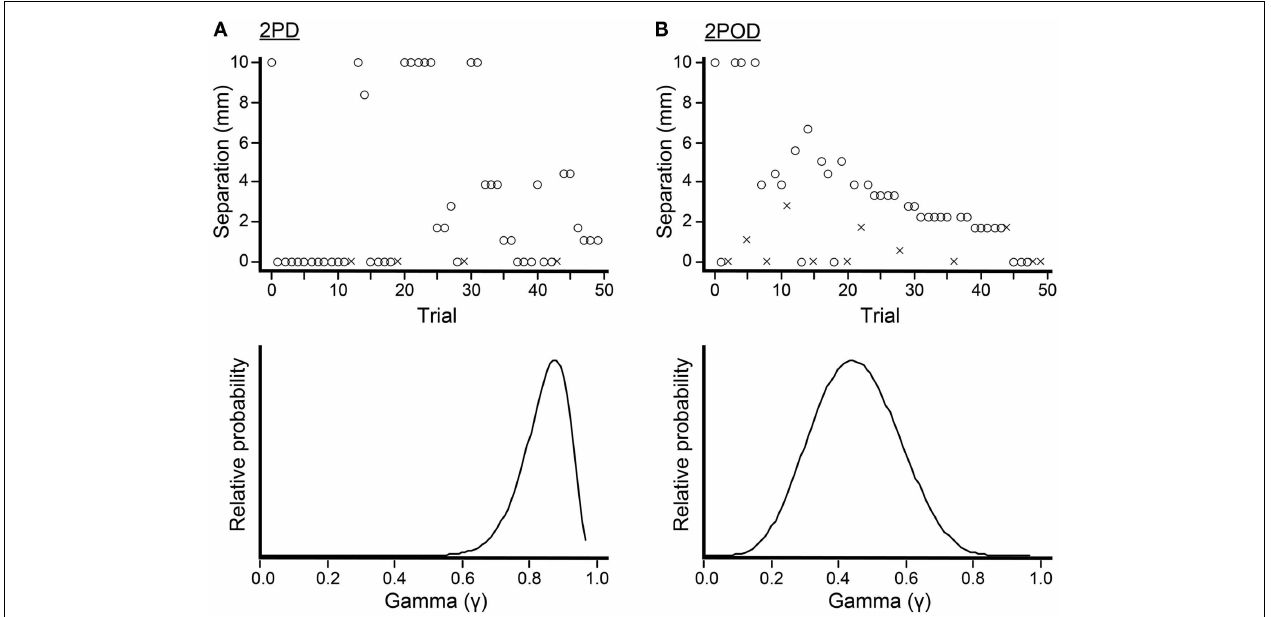
correctly on 21/25 = 84% of 2PD trials, compared to 6/13 = 46% of 2POD trials.The Bayesian adaptive procedure does not follow a preset stimulus sequence or simple staircase algorithm, but rather selects the separation on each trial that is expected to provide the most information regarding the shape of the participant’s psychometric function.